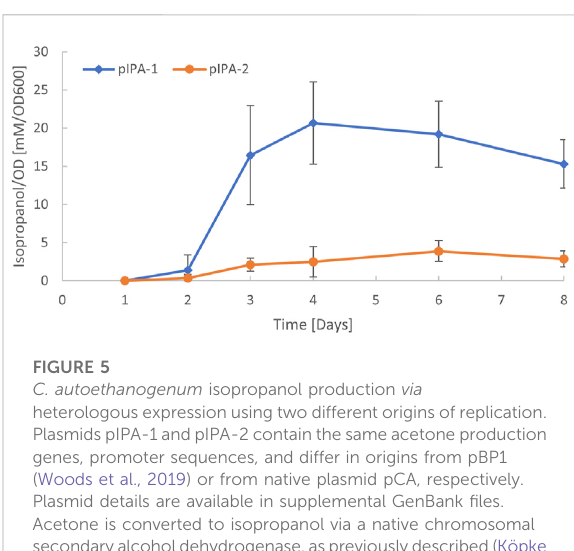
FIGURE 5 C. autoethanogenum isopropanol production via heterologous expression using two different origins of replication. Plasmids pIPA-1 and pIPA-2 contain the same acetone production genes, promoter sequences, and differ in origins from pBP1 (Woods et al., 2019) or from native plasmid pCA, respectively. Plasmid details are available in supplemental GenBank fi les. Acetone is converted to isopropanol via a native